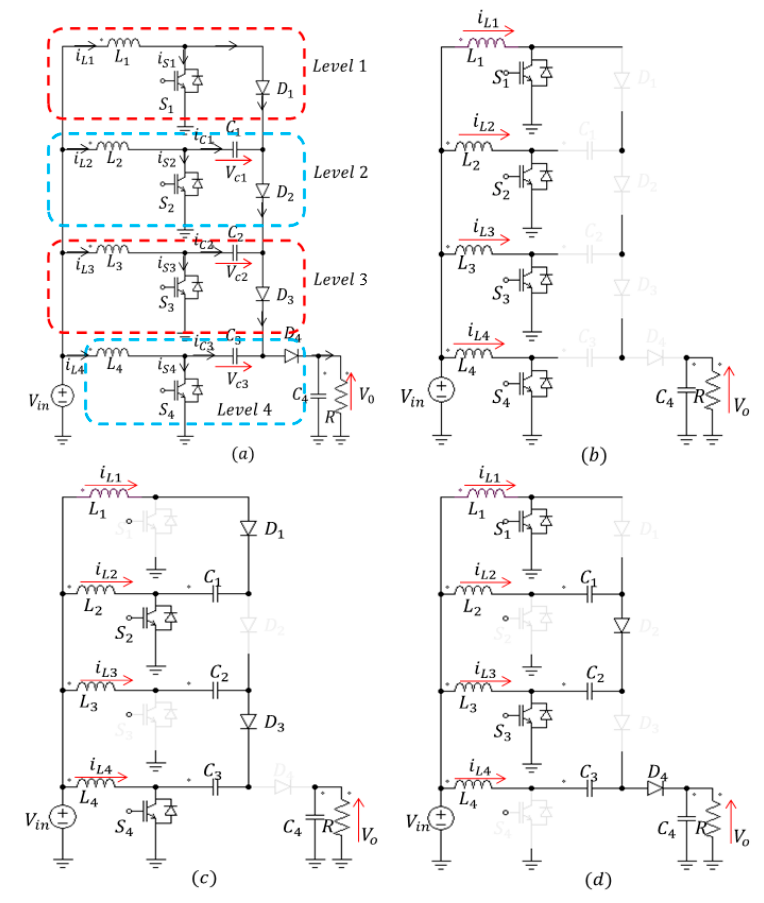
Figure 3. Proposed converter ( a ), the operating states: 1 ( b ), 2 ( c ) and 3 ( d ). Electronics 2020 , 9 , x FOR PEER REVIEW